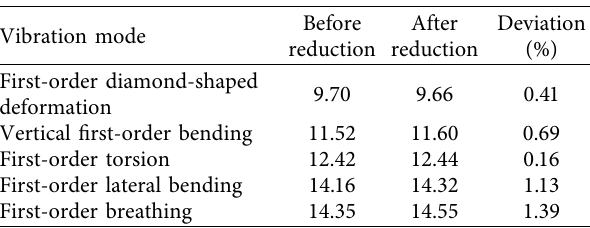
Table 1: Car body elastic modal frequencies (Hz).